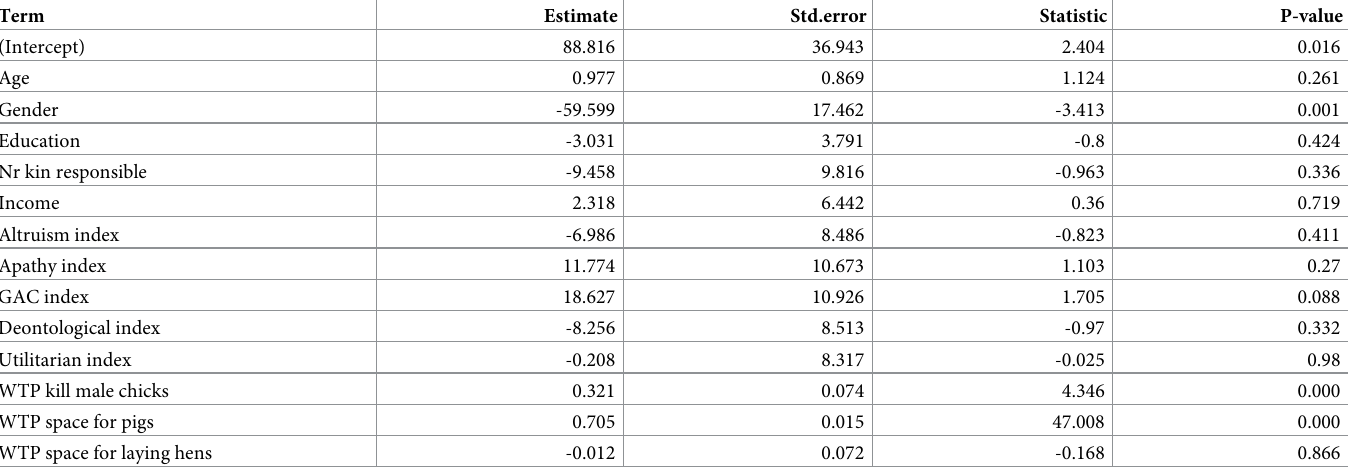
Table 5. Regression analysis for the WTP for pain relief for piglet castration (df = 1203, adjusted R-squared: